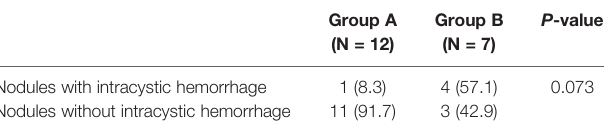
TABLE 3 | Comparison of intraoperative intracystic hemorrhaging between two groups of nodules with rich blood supply.